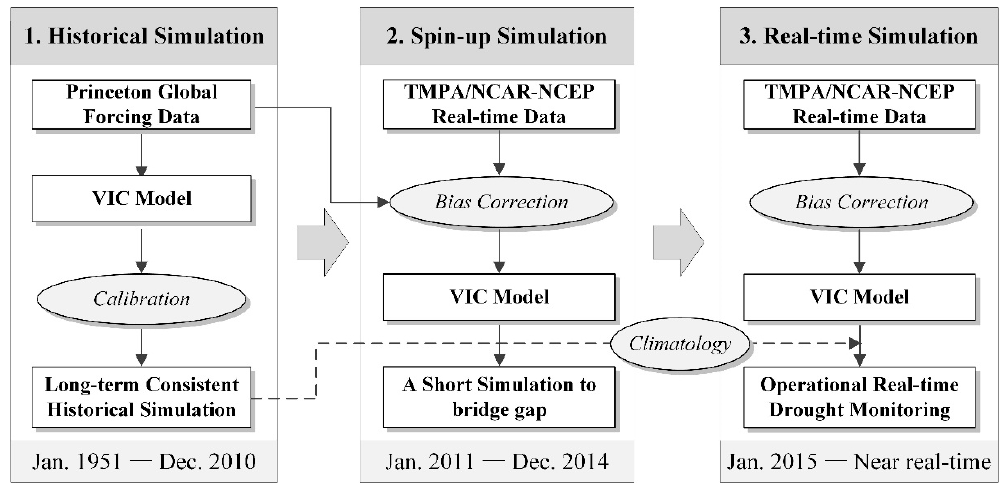
Figure 4. Configuration of the operational Lancang–Mekong drought monitor (LMDM).